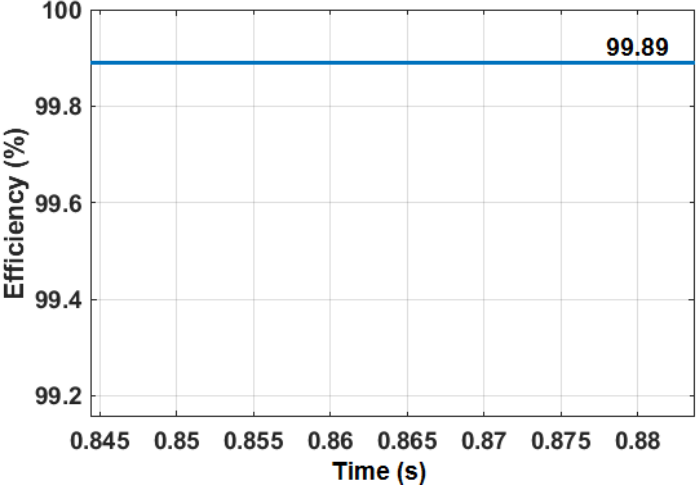
Figure 8. Efficiency of Neural Network – Improved Particle Swarm Optimization (NN – IPSO).